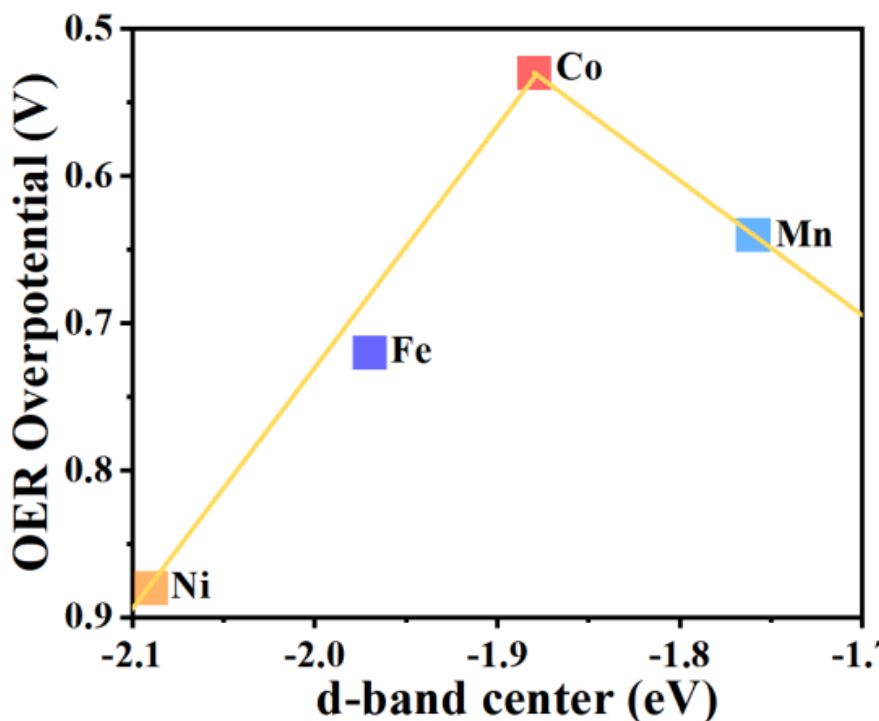
Figure 8. The volcano curve of OER overpotential as a function of the d-band center ( ε d